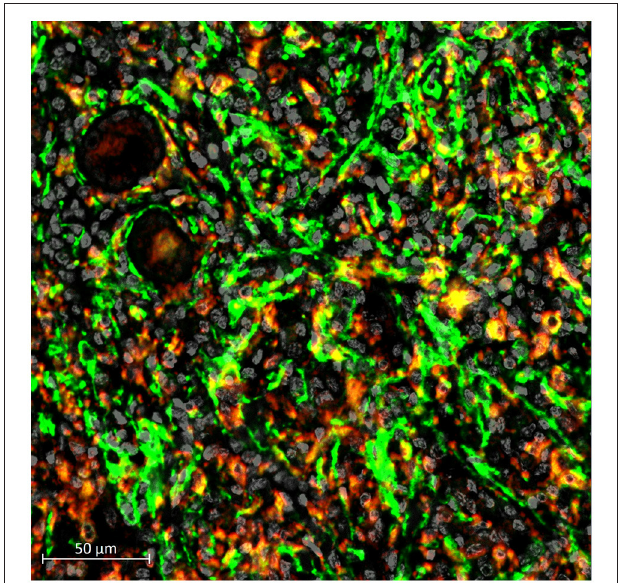
FIGURE 1 | Occurrence of MMT (yellow) in a human kidney with chronic allograft dysfunction, indicating by the presence of macrophage (CD68, red) expressing myofibroblast marker (alpha-SMA,